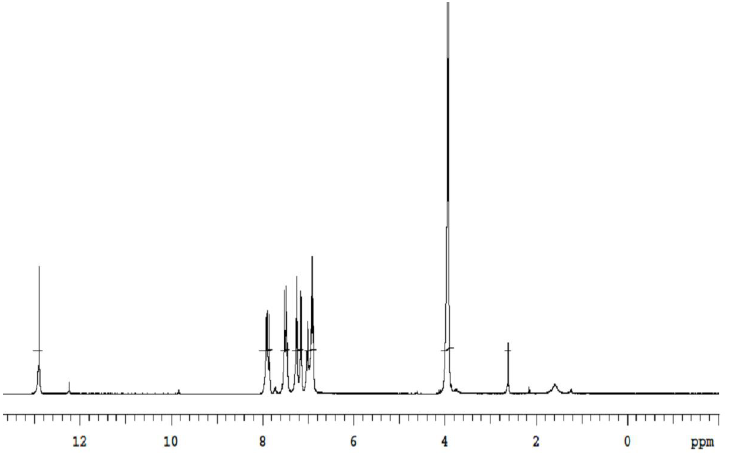
Figure 2. 1 H NMR Spectrum of 2'-hydroxy-3,4-dimethoxy chalcone